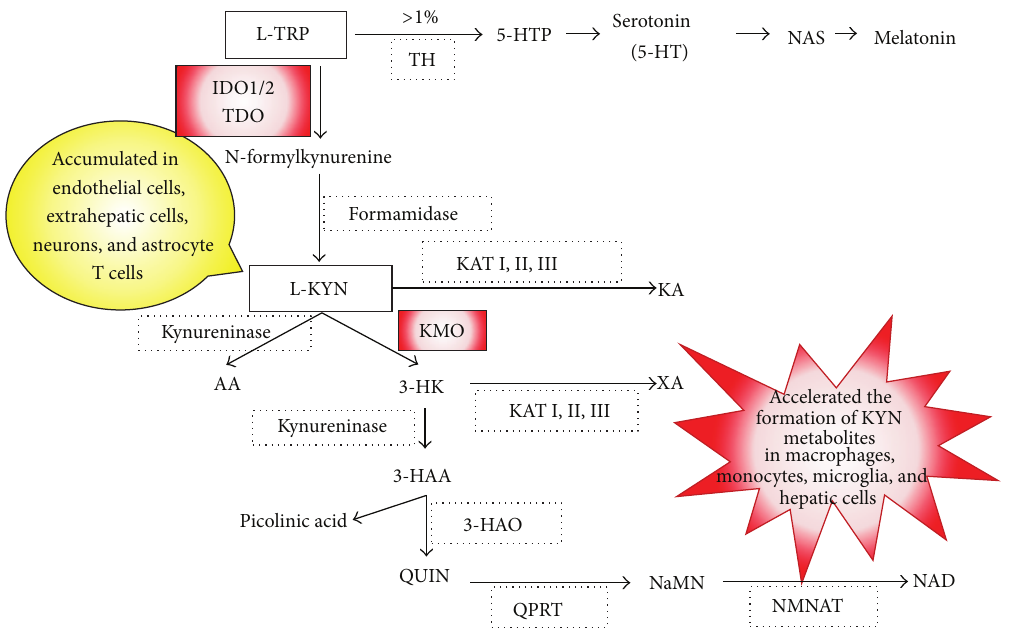
Figure 1: Schematic overview of the kynurenine pathway. It is estimated that only 1% of dietary tryptophan (TRP) can be converted into serotonin (5-HT). The remaining 99% of TRP is metabolized via the kynurenine (KYN) pathway. Tryptophan hydroxylase (TH), 5-hydroxy TRP (5-HTP), N-acetylserotonin (NAS), indoleamine 2,3-dioxygenase 1 and 2 (IDO1/2), tryptophan 2,3-dioxygenase (TDO), kynurenine 3-monooxygenase (KMO), kynurenine aminotransferase (KAT I, II, III), kynurenic acid (KA), anthranilic acid (AA), 3- hydroxykynurenine (3-HK), xanthurenic acid (XA), 3-hydroxyanthranilic acid (3-HAA), 3-hydroxyanthranilic acid oxidase (3-HAO), quinolinic acid (QUIN), quinolinic-acid phosphoribosyl transferase (QPRT), nicotinic acid mononucleotide (NaMN), nicotinamide mononucleotide adenylyltransferase (NMNAT), nicotinamide adenine dinucleotide (NAD).